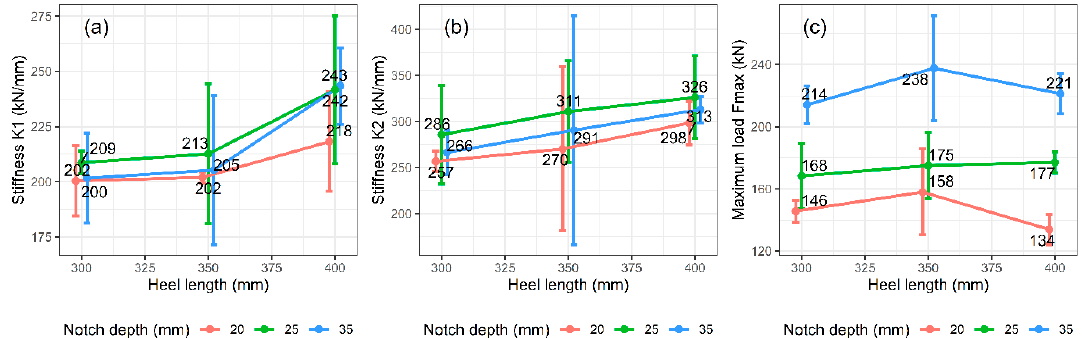
Figure 6. Sti ff ness K1 ( a ), K2 ( b ), and maximum load Fmax ( c ) of di ff erent notch depths. Figure 6. Stiffness K1 ( a ), K2 ( b ), and maximum load Fmax ( c ) of different notch depths.